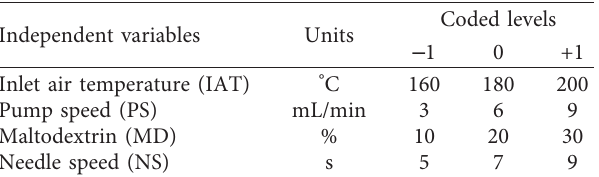
Figure 1: The schematic diagram of the lab-scale spray dryer (TPS-15). Table 1: Coded and actual levels of independent variables for optimization of response factors as determined by central com- posite design